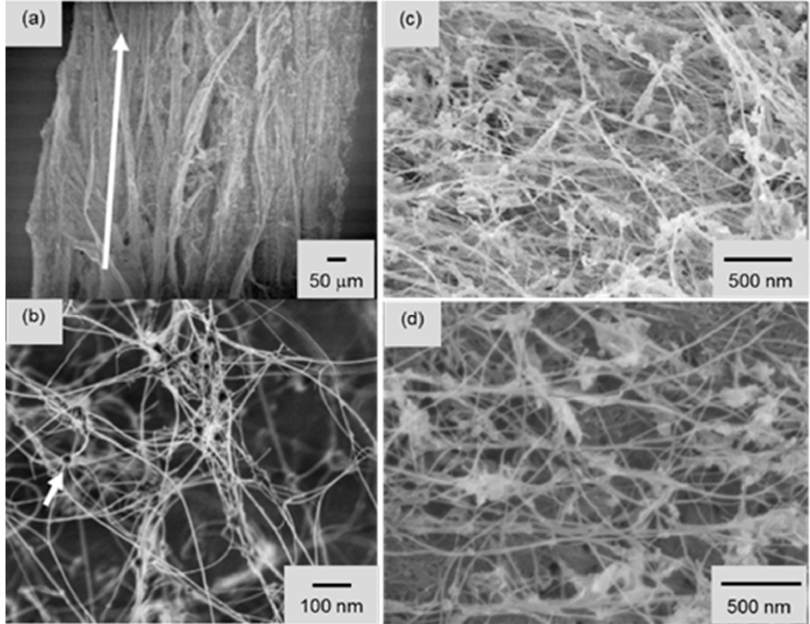
Figure 2. SEM images of ( a ) BNNT fibrils and ( b ) the entangled BNNT network produced by the pressurized vapour/condenser method (PVC). The white arrow in ( a ) indicates the growth direction, parallel to the BNNT fibrils. The short arrow in ( b ) marks a round, solidified boron droplet in the network. Adapted with permission from [43]. Copyright 2009 IOP Publishing Ltd.; ( c ) Entangled BNNTs within the BNNT fibrils grown from hydrogen catalysed inductively coupled plasma. Adapted with permission from [46]. Copyright Published 2014 by American Chemical Society; ( d ) Image of entangled BNNT fibril produced by the EPIC system. Adapted with permission from [47]. Copyright 2014